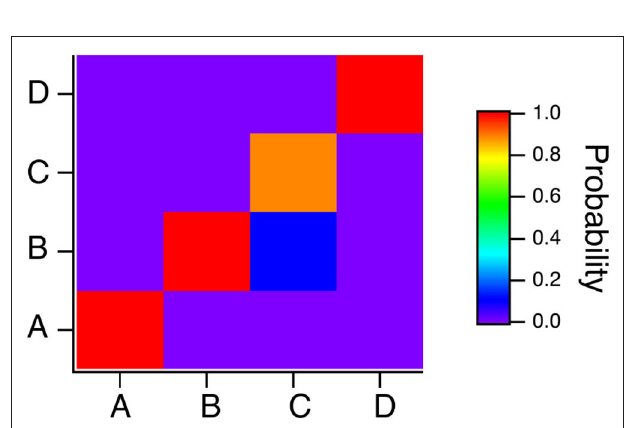
FIGURE 13 | Confusion matrix for identifying the four Sprott systems A,B,C and D with the polynomial ODE reservoir computer when p 1 = − 0.5, the time constant T 0 = 0.3 and the spectral radius σ = 0.8. Along the x axis are the actual Sprott systems, while the y axis shows the probability that the Sprott system will be identified as that particular